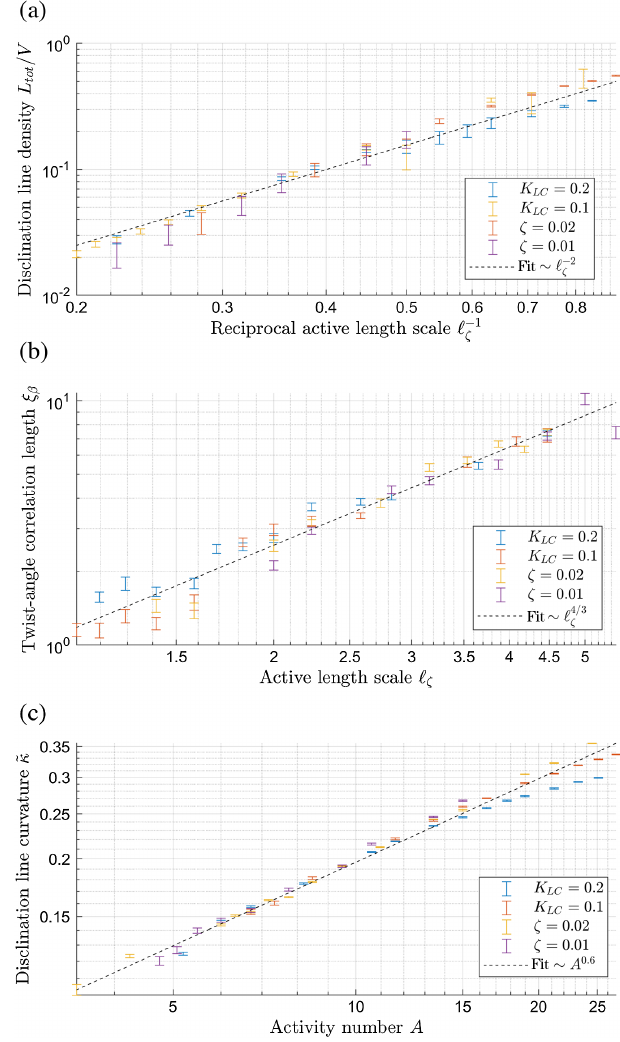
FIG. 7. (a) Mean area density of disclination lines, defined as the total length L of all disclination lines divided by the tot volume V , as a function of the inverse active length scale ffiffiffiffiffiffiffiffiffiffiffiffiffi p 1 = l ζ =K or ζ are varied, while the other . Either K ζ ¼ LC LC parameter is set to a fixed value, which is indicated by the legend entries. (b) Persistence length ξ β of the twist angle β as a function of the active length scale. (c) Mean curvature ˜ κ of disclination lines as a function of activity number A ¼ R= l ζ . Averaging performed over T ¼ 20 000 time